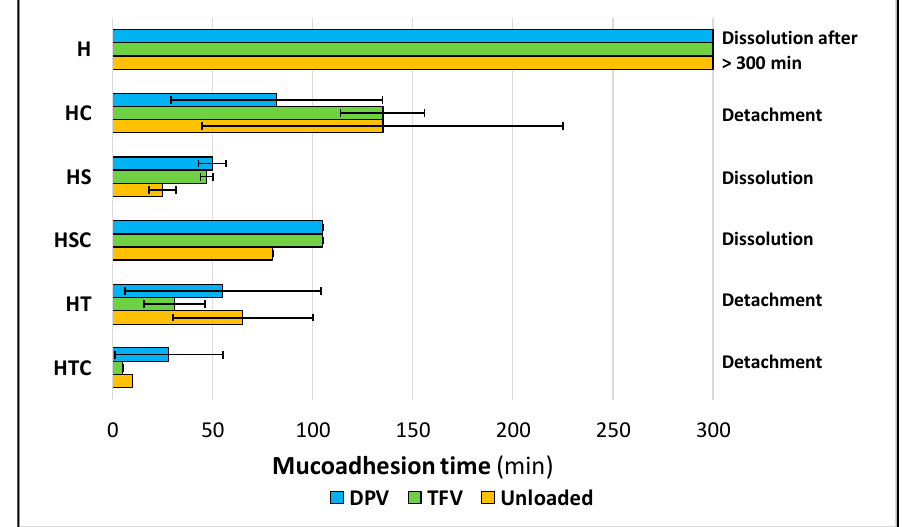
Figure 13. Mucoadhesion time until the detachment of the vaginal discs. At right is detailed if mucoadhesion time is limited by the detachment or complete dissolution of the disc. Mean ± SD are presented ( n = 2).